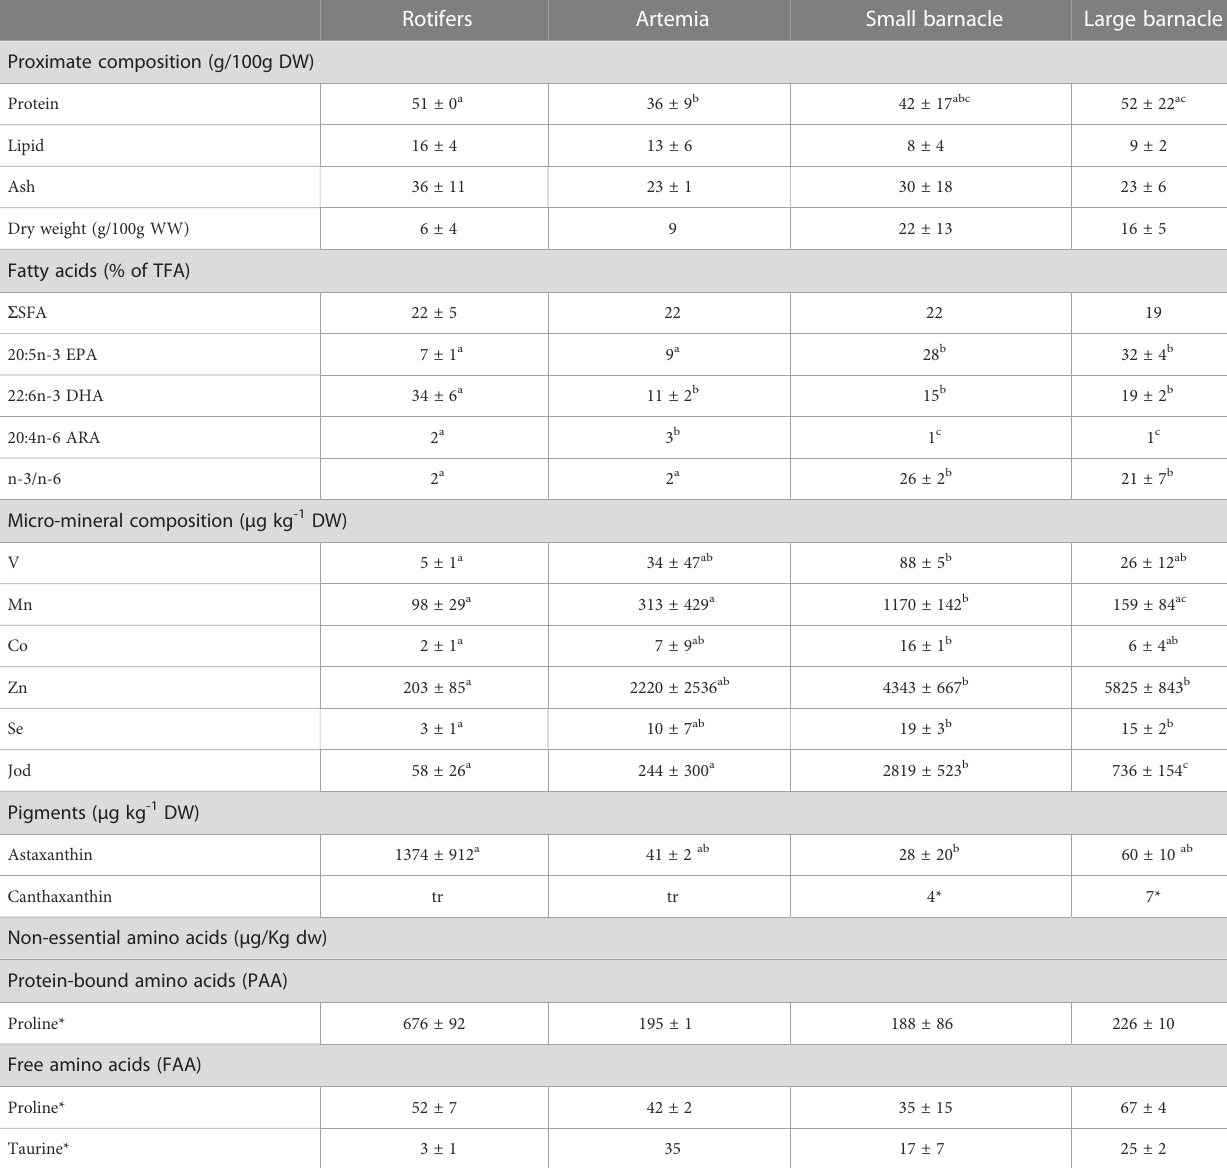
TABLE 2 Overview of the selected nutritional analyses in rotifers, artemia, small barnacle ( Balanus crenatu ), and large barnacle ( Semibalanus balanoides)